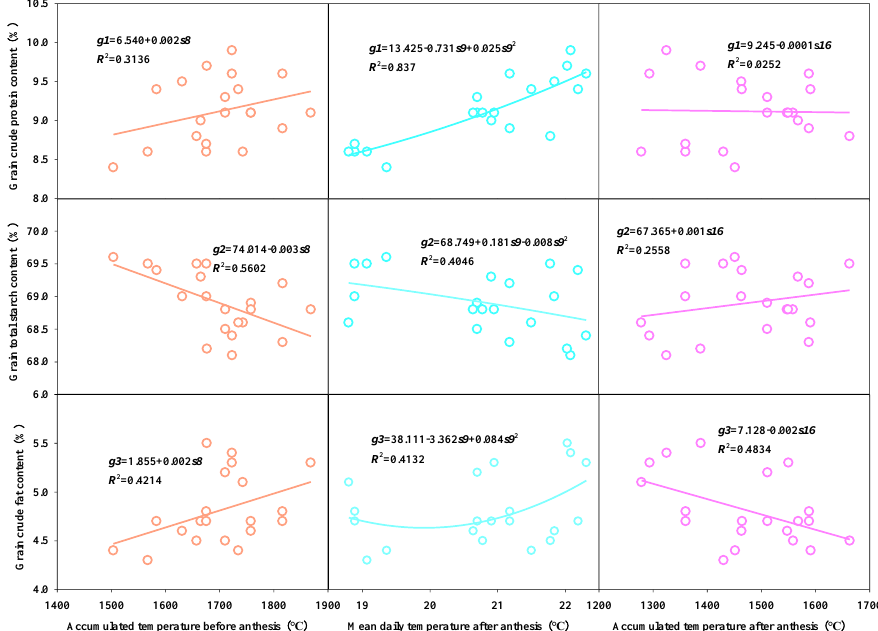
Figure 6. Regression analysis of selected meteorological factors and grain nutritional quality.